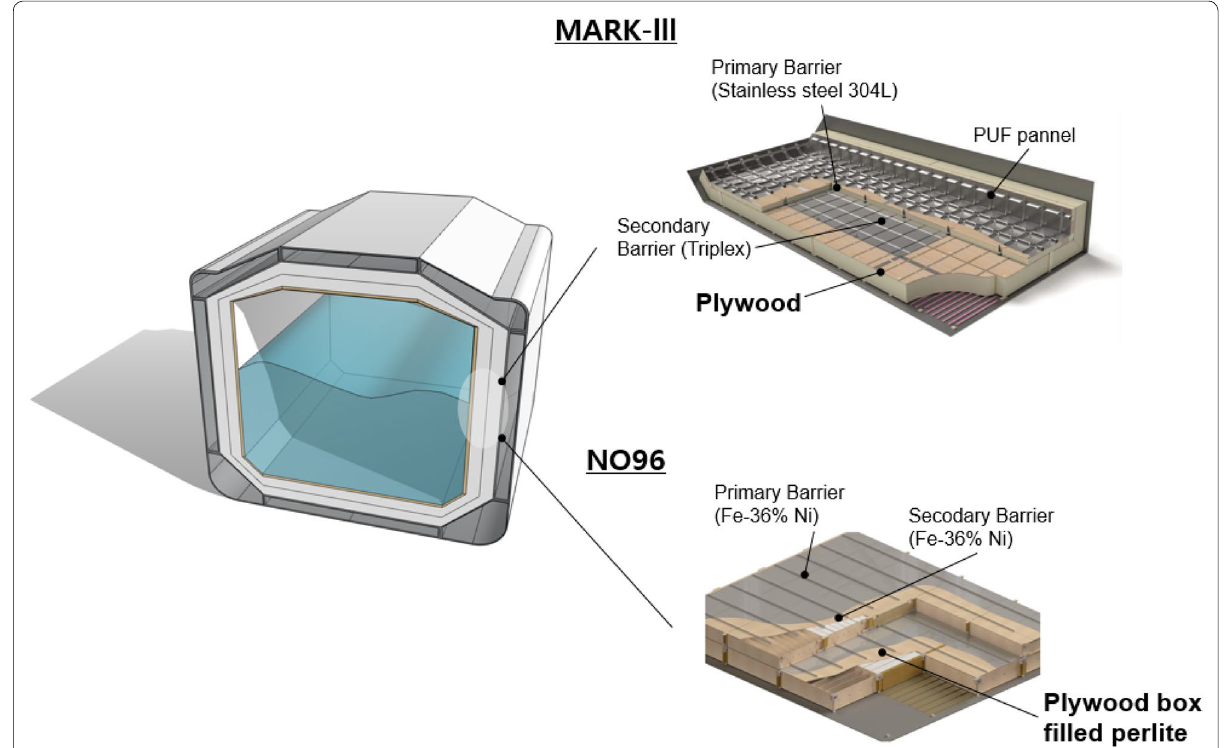
Fig. 1 GTT membrane‑type LNG cargo containment system: a NO96 and b